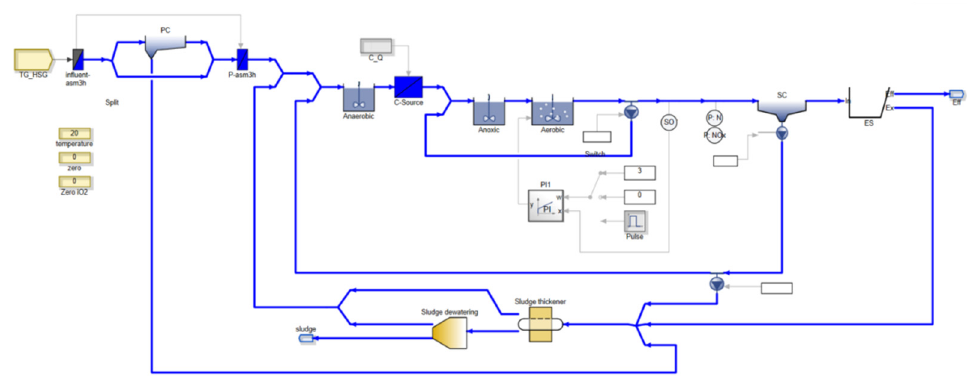
Figure 4. Basic model of the example WWTP in SIMBA.